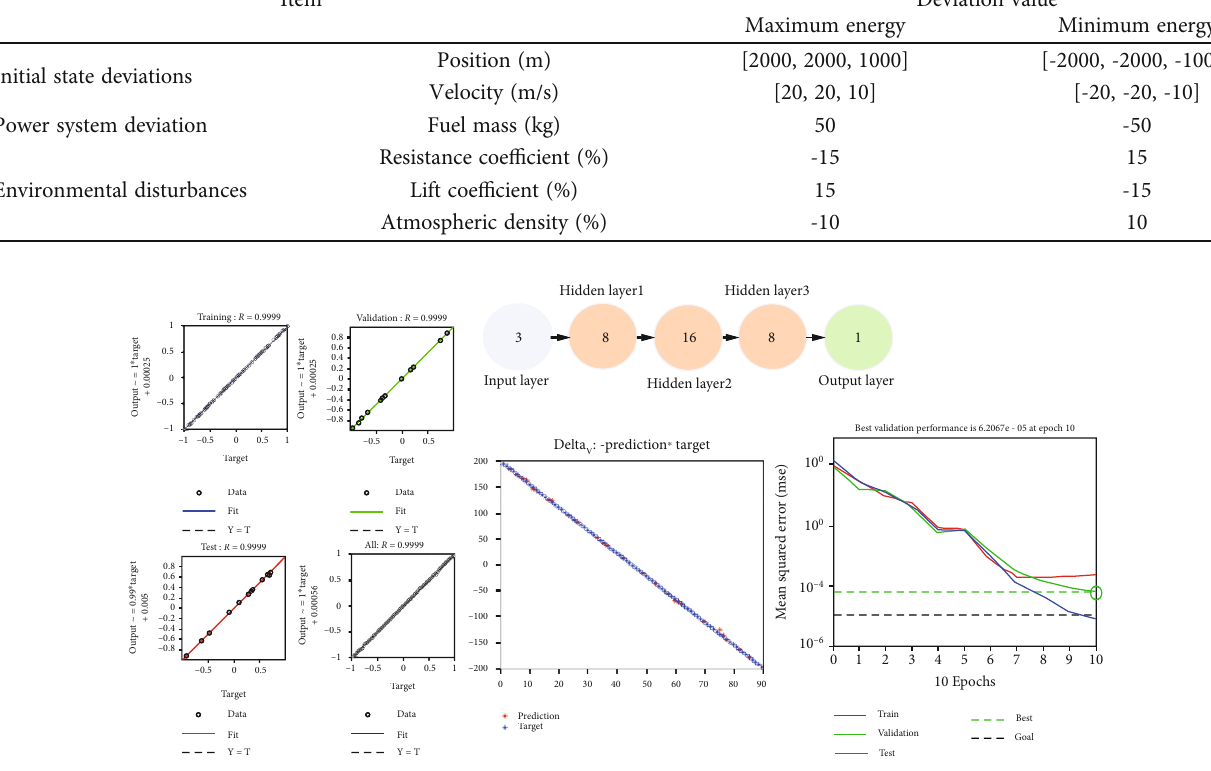
Figure 9: Training results of velocity neural